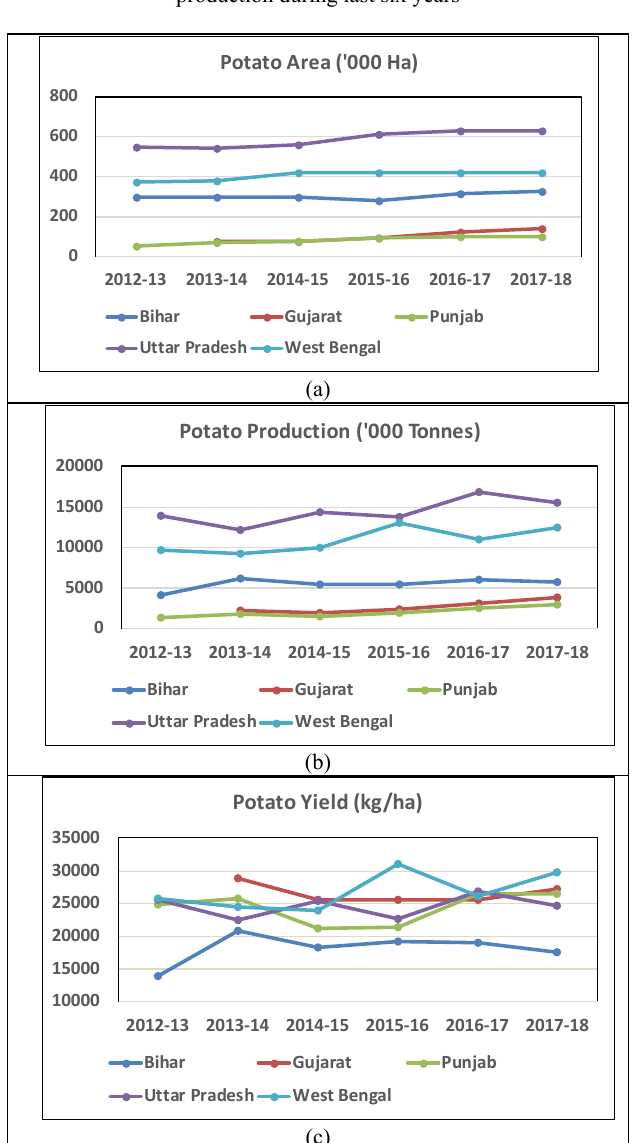
Figure 5: Trend of state level estimated Potato area, production and yield trend during last six years at state level